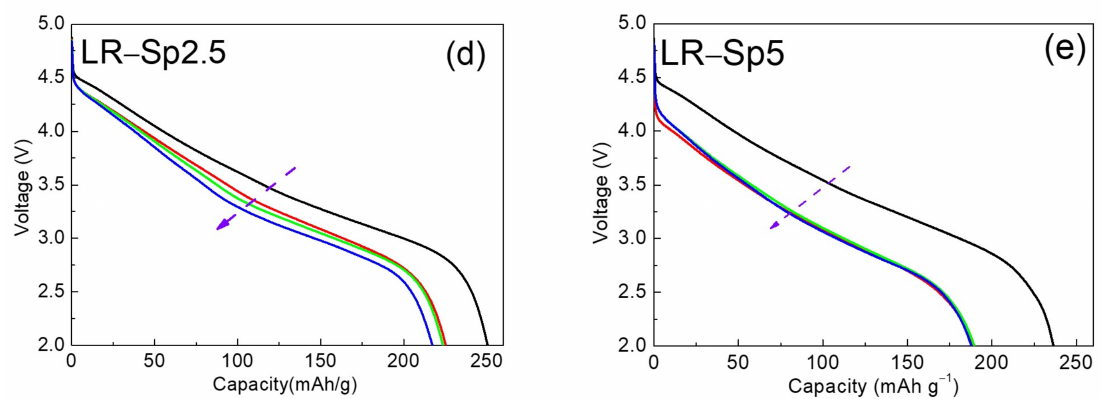
Figure 11. ( a ) Cycle life performance and discharge profiles for the 10th, 20th, 30th, and 40th cycles for ( b ) LR–Bare, ( c ) LR–Sp1, ( d ) LR–Sp2.5, and ( e ) LR–Sp5 cathodes at 2.0–4.9 V.